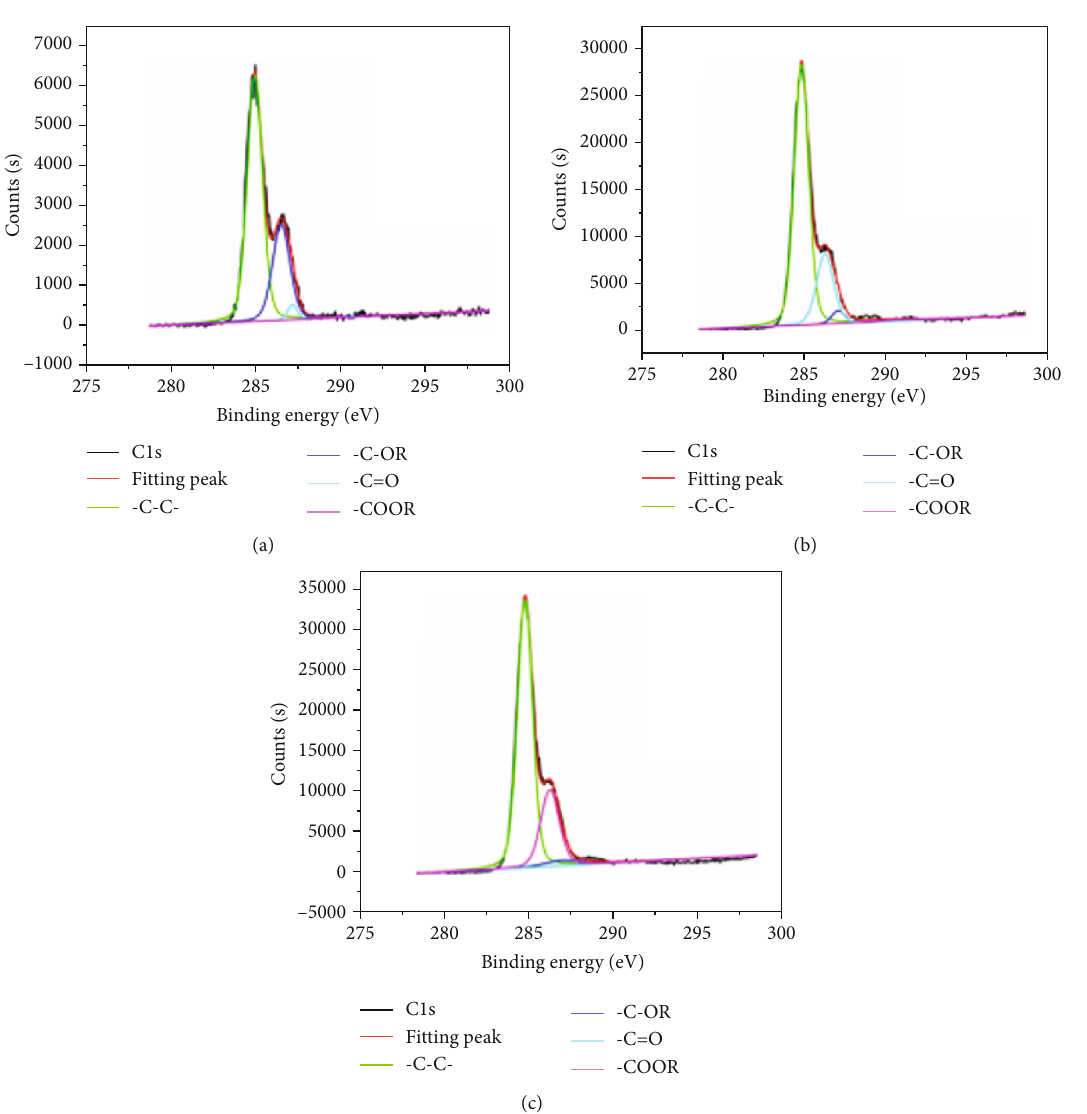
Figure 5: The XPS narrow scanning results of C1s fi tting peak: (a) CCF800A; (b) CCF800B; (c) CCF800C.